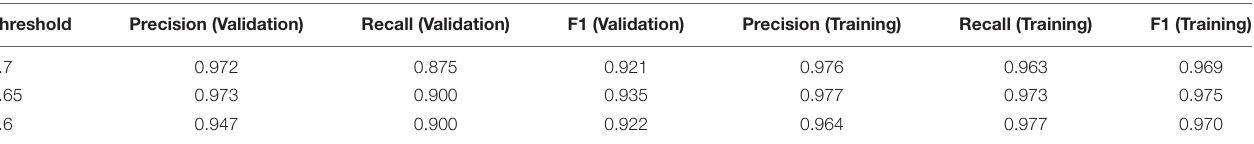
FIGURE 4 | (A) Results of random forest (RF) algorithm (red) using a threshold of 0.7 compared with known archaeological deposits (yellow circles) and non-archaeological areas (green circles). (B) Visualization of band separability between archaeological and non-archaeological training data. All band differences are statistically significant ( p < 0.001). (C) Close up of known archaeological and non-archaeological sites. All but one are correctly identified. (D) Another area with anthropogenic activity (forest clearings indicated by arrows) and known archaeological sites. Imagery © 2020 Planet Labs. Inc. TABLE 1 | Accuracy assessment of random forest